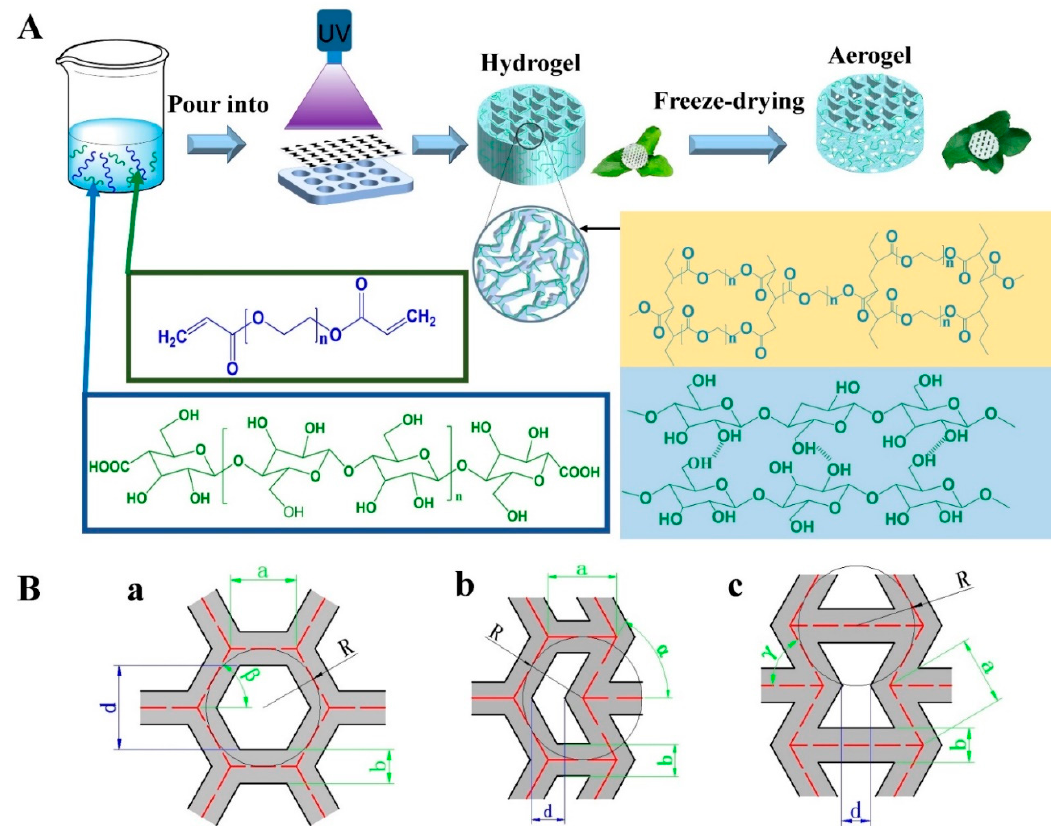
Figure 1. ( A ) Schematic flow diagram showing CNF/PEGDA aerogel scaffold preparation. ( B ) Geometric blueprints for three different Poisson’s ratio structures: ( a ) positive Poisson’s ratio (PPR); ( b ) negative Poisson’s ratio (NPR); ( c ) zero Poisson’s ratio (ZPR).